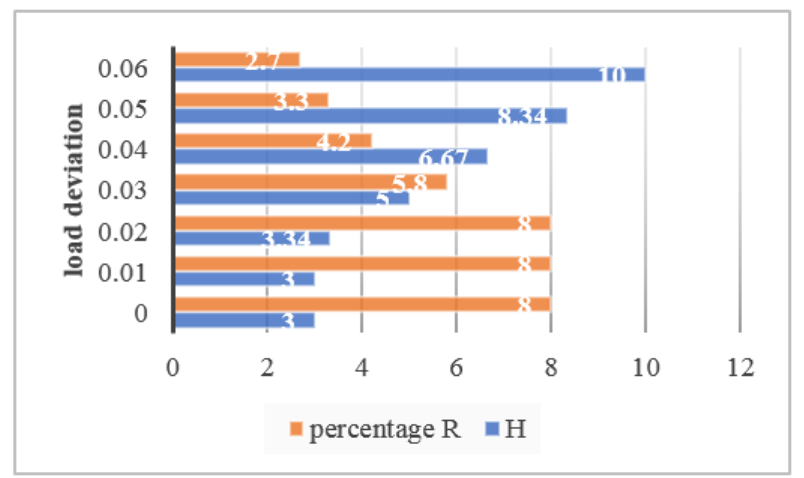
Figure 17. Adaptive parameter determination according to various demands.